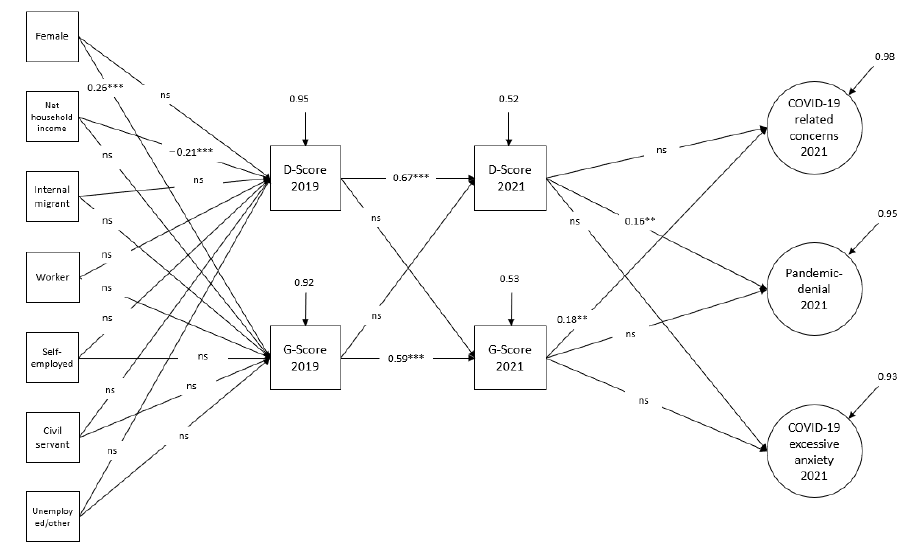
Figure 3. Influence of socio-demographic variables on health variables in the cross-lagged model to explain COVID-19 attitudes, MLR estimation. χ 2 = 254.304 (df = 169, p < 0.001), RMSEA = 0.041, CFI = 0.936, TLI = 0.921, SRMR = 0.057. **, *** significant at the 5% or 1% level. The measurement model of COVID-19 attitudes as well as residual correlations between the factors are not shown here. Observed variables are represented by rectangles and latent variables by circles. Direct effects are depicted by unidirectional arrows. Arrows without “emitting” variables represent the measurement error of the respective variable.